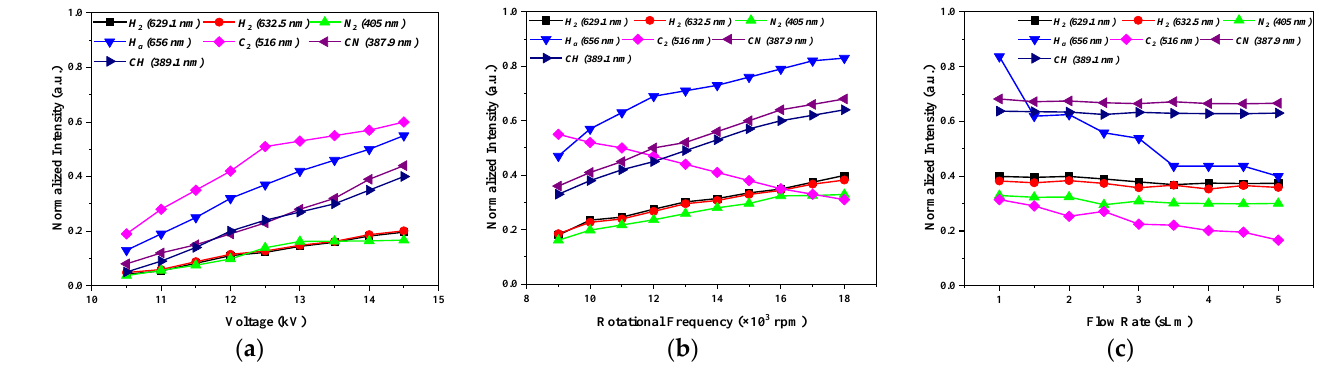
Figure 9. The normalized intensities of generated species in the plasma discharge versus ( a ) different voltages applied on the stationary power electrode at 1 sLm gas flow rate, ( b ) rotational frequencies of the power electrode at 14 kV applied voltage and 1 sLm gas flow rate, and ( c ) gas flow rates at 14 kV applied voltage and 18,000 rpm rotation frequency of the power electrode.